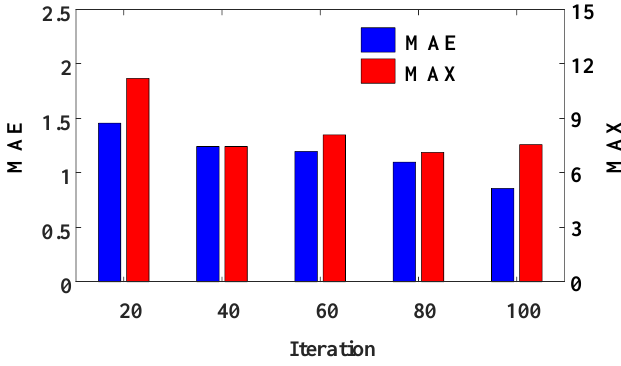
Figure 11. Performances at different values of iteration.